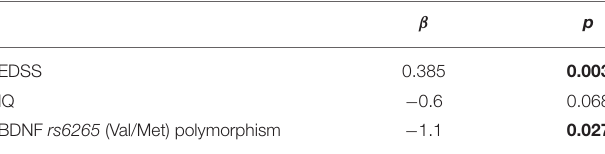
TABLE 2 | Predictors of number of failed neuropsychological tests based on a linear regression model.